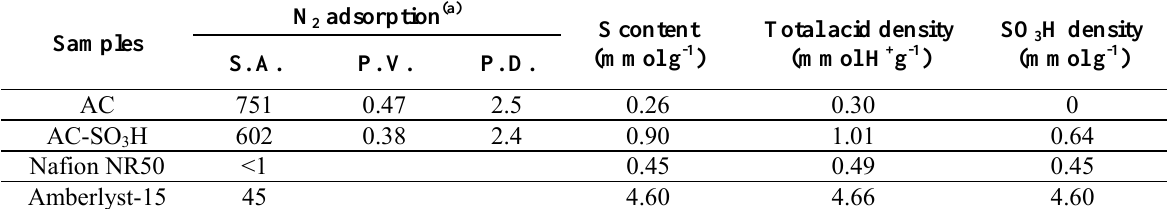
Figure 2. S 2p XPS spectrum of AC-SO